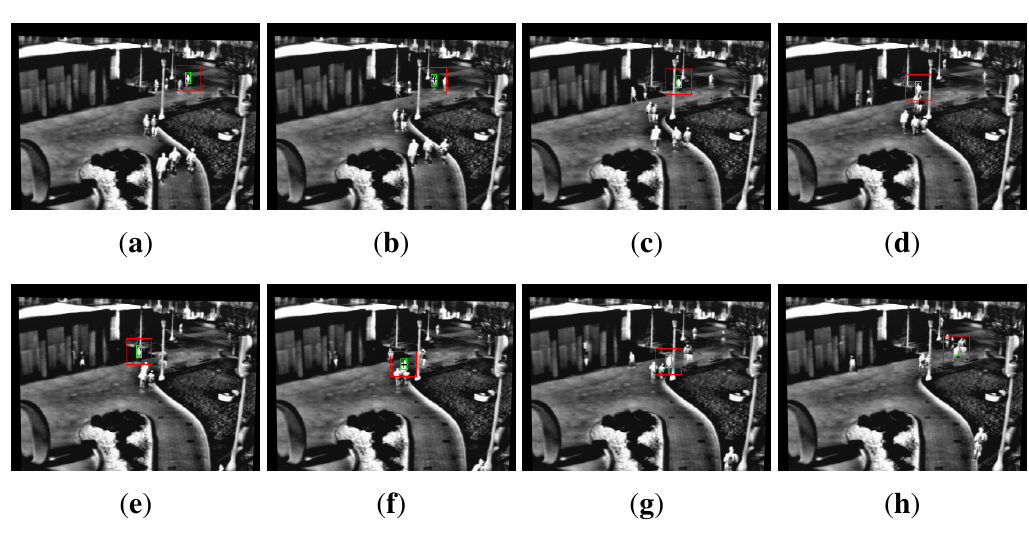
Figure 5. Tracking results with the proposed algorithm for sequence otcbvs 03-l1s1ir-12. ( a ) Frame 142; ( b ) Frame 188; ( c ) Frame 249; ( d ) Frame 333; ( e ) Frame 391; ( f ) Frame 407; ( g ) Frame 458; ( h ) Frame